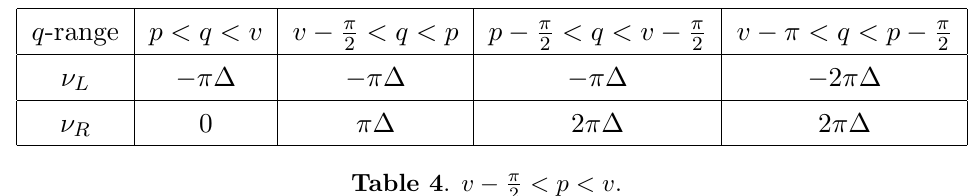
Table 4 . v (cid:0) (cid:25)